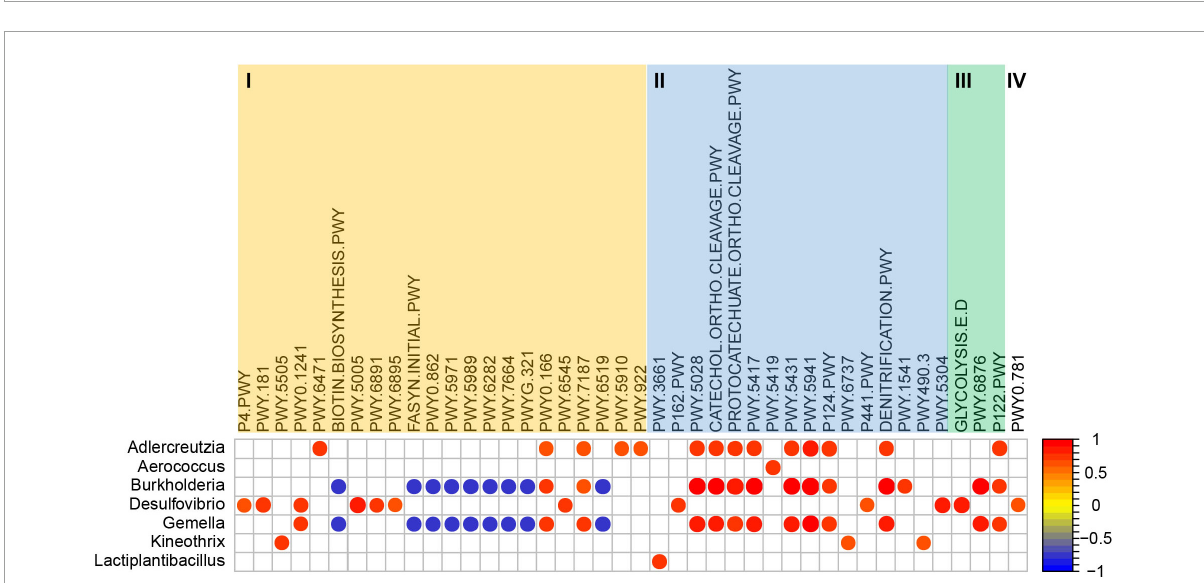
FIGURE5 Coefficient relationship between differential bacteria (genus level) and metabolic pathways analyzed using PICRUSt2 based on the 16S rRNA amplicon data. Only results with p < 0.05 and correlation coefficient > 0.68 or < –0.68 are shown in the figure. I = Biosynthesis; II = Degradation/Utilization/Assimilation; III = Generation of precursor metabolites and energy; IV =